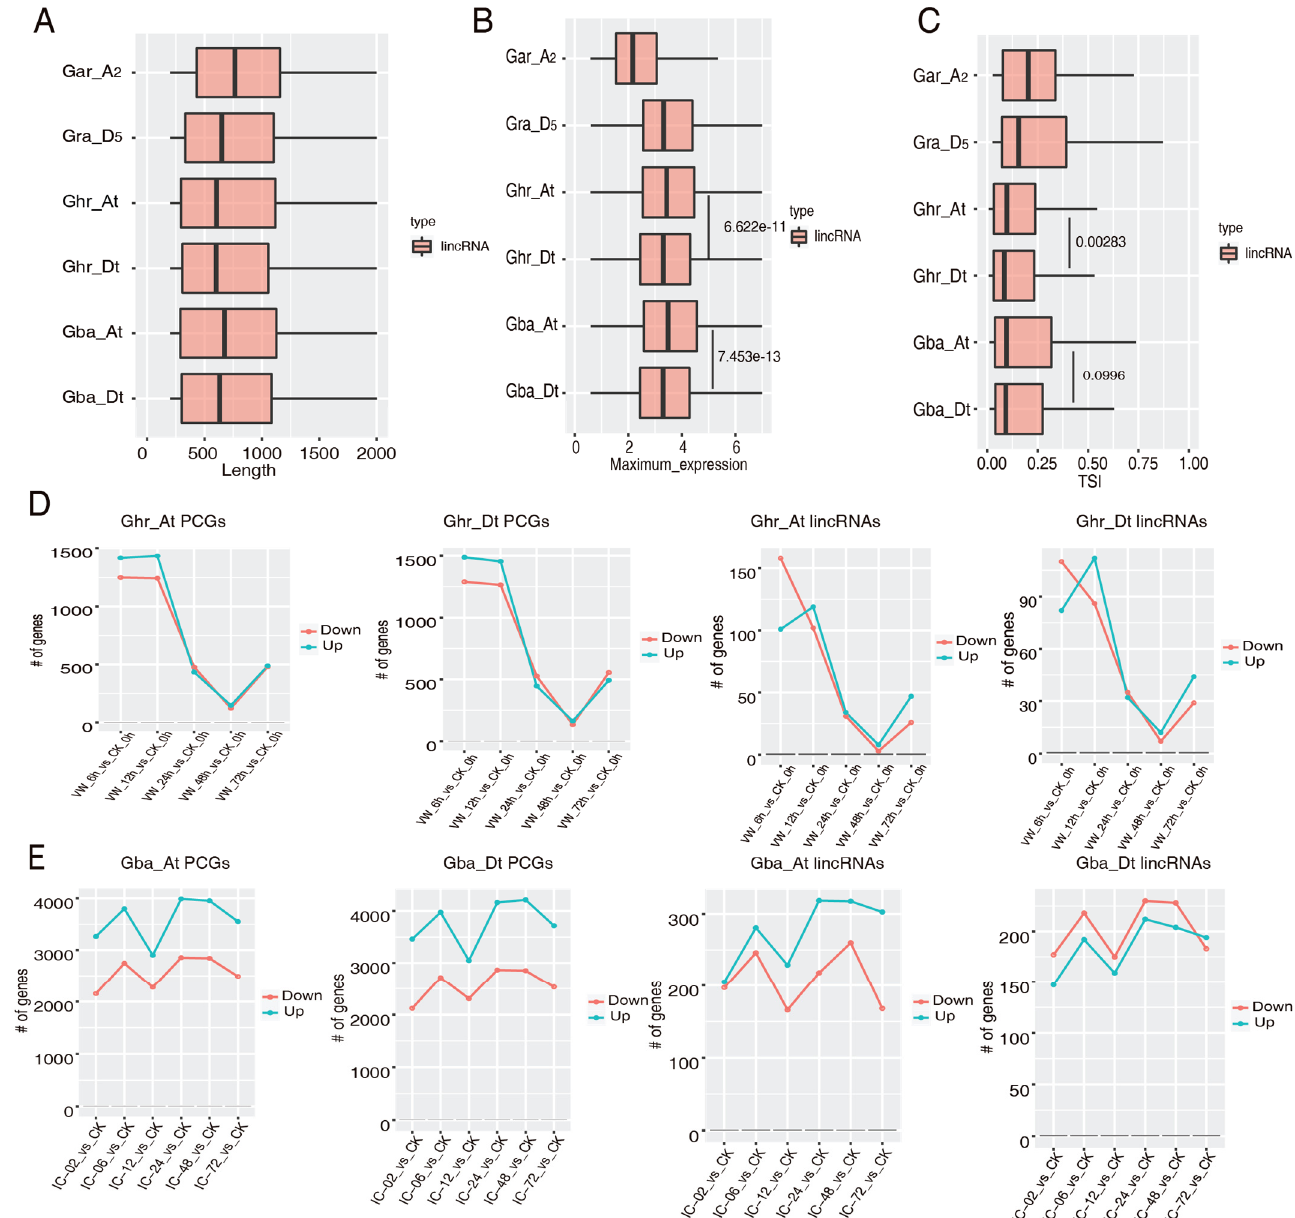
Figure 4. Subgenome dominance of the Verticillium dahliae ( Vd )-responsive lincRNAs. ( A ) Comparison of the length of the Vd -responsive lincRNAs from the six cotton (sub)genomes. ( B ) Comparison of the maximum expression level (log2 transformed) of the Vd -responsive lincRNAs from the six cotton (sub)genomes. ( C ) Comparison of the expression specificity of the Vd -responsive lincRNAs from the six cotton (sub)genomes. ( D ) Comparison of the number of differentially expressed protein coding genes (PCGs) and lincRNAs in the Vd -infected samples in the two subgenomes of Ghr. ( E ) Comparison of the number of differentially expressed PCGs and lincRNAs in the Vd -infected samples in the two subgenomes of Gba.